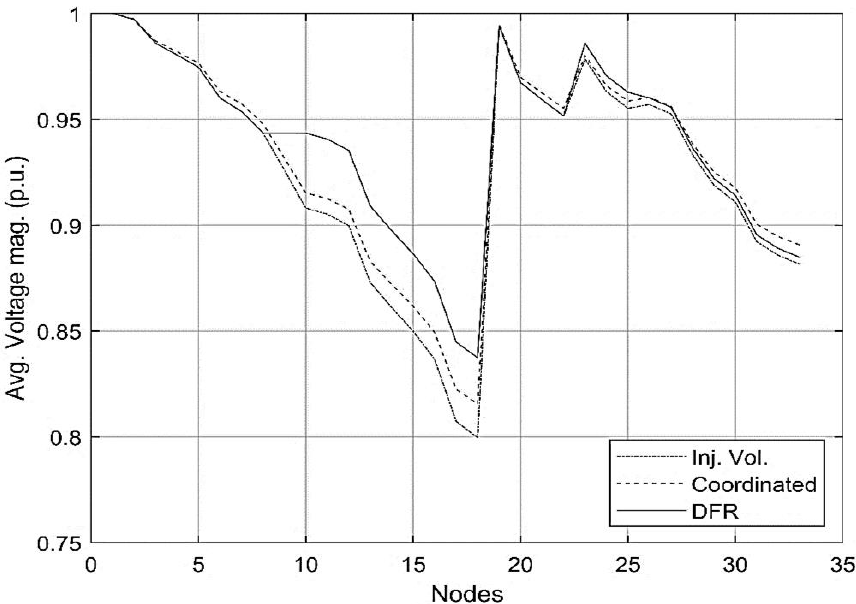
Figure 7. Voltage (p.u.) comparison of three techniques.